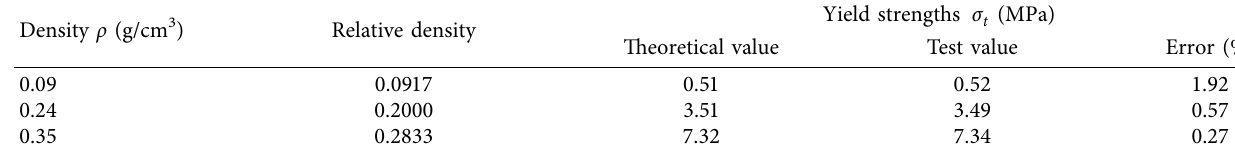
Table 5: Yield strength calculation results.